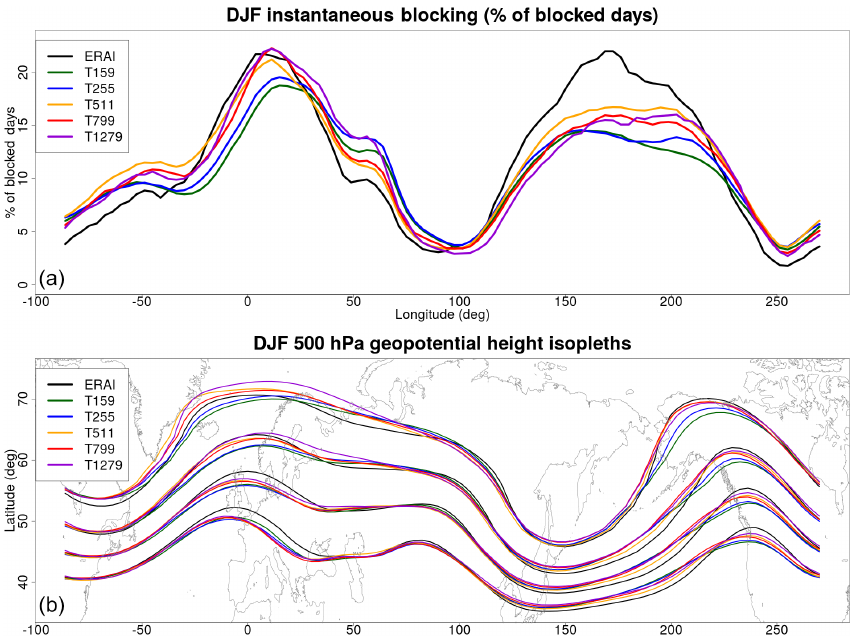
Figure 9. (a) Ensemble mean blocking frequencies following D’Andrea et al. (1998) for the different PDA experiments. Members of deter- ministic and stochastic experiments have been combined together for each resolution. ERA-Interim for the 1979–2008 period is shown as comparison in black. (b) December–January–February (DJF) climatological mean for geopotential height at 500hPa for the ensemble mean of PDA experiments. Only 5200, 5300, 5400 and 5500m isopleths are